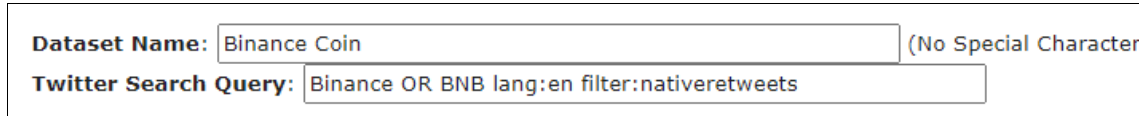
Figure 2(b). Twitter search query for Ethereum in Netlytic